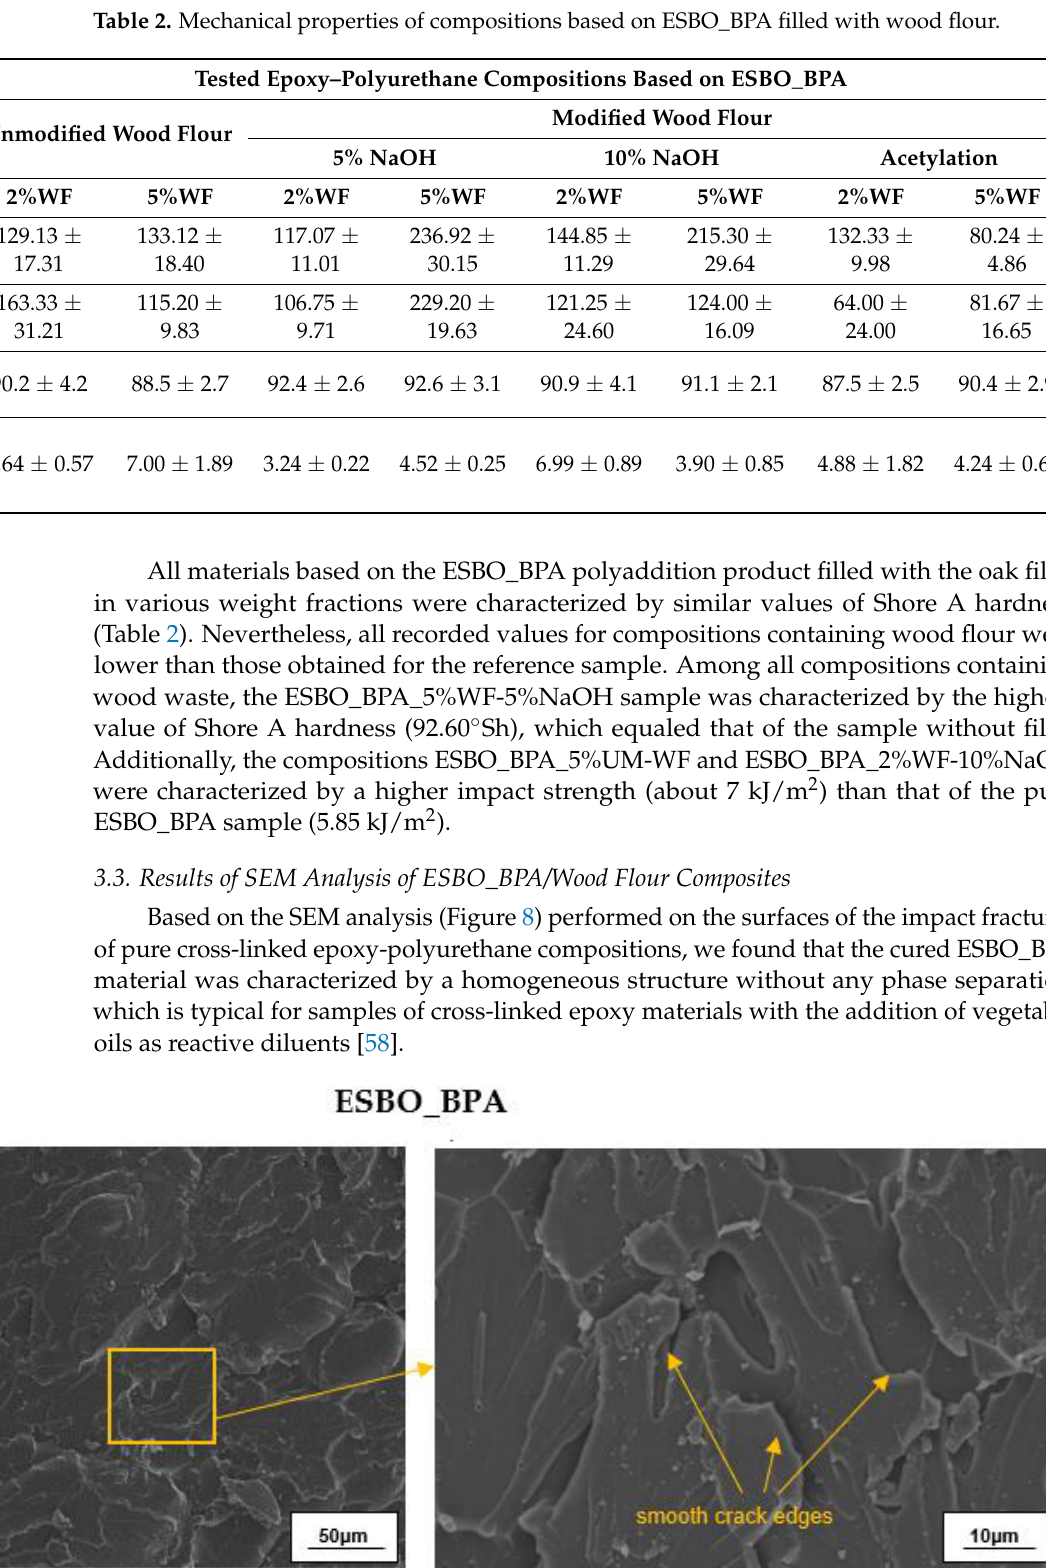
Table 2. Mechanical properties of compositions based on ESBO_BPA filled with wood flour.